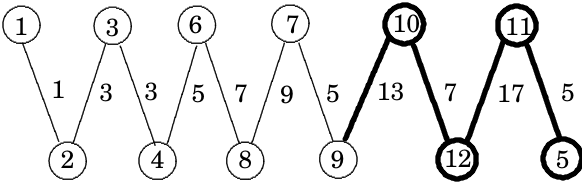
Figure 5: The construction of a rainbow mean coloring c